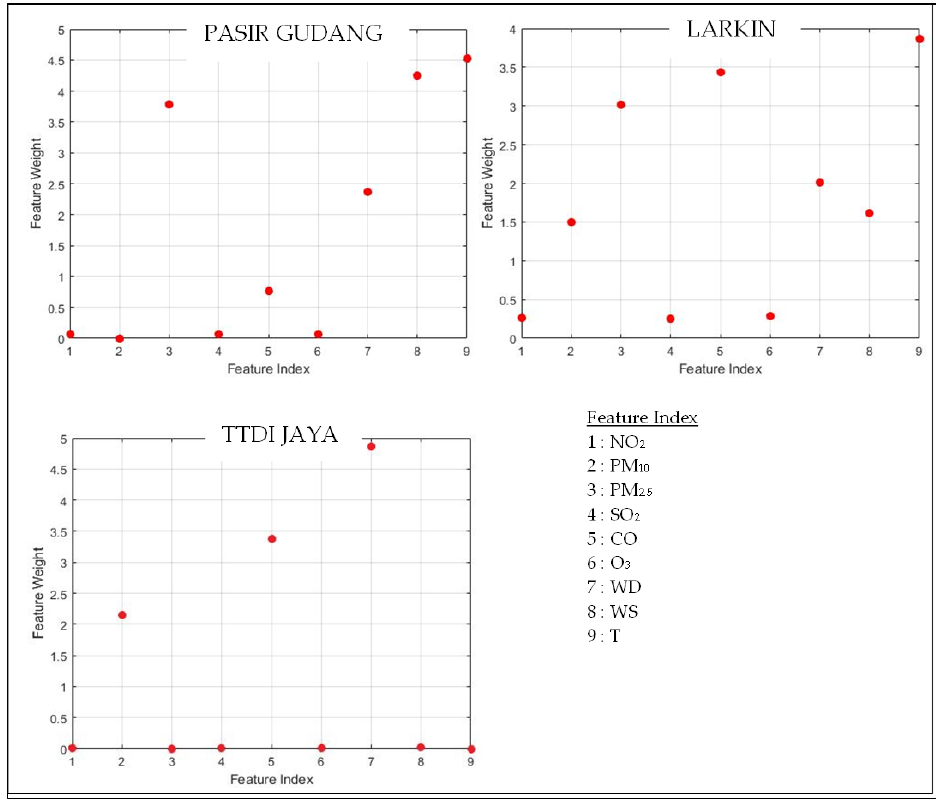
Figure 5. The parameter weights for each monitoring station based on the NCA for the parameter selection process. Table 3. The RMSE and R 2 for all and relevant parameters.